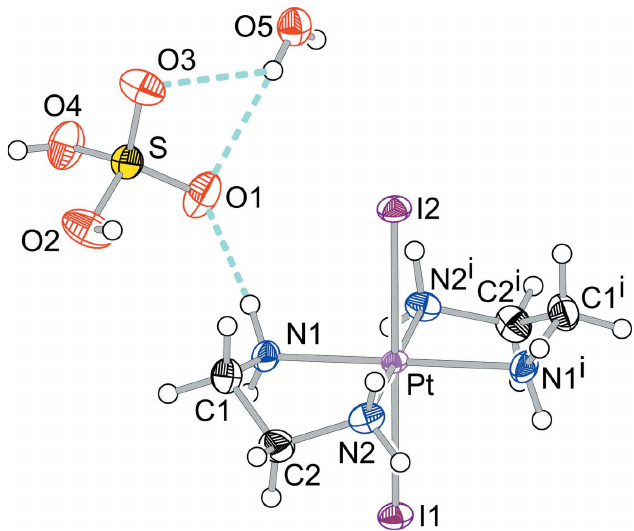
Figure 1 The structures of the molecular components of (I), showing the atomic numbering scheme. Displacement ellipsoids are drawn at the 50% probability level for non-H atoms. Light-blue dashed lines represent N— H (cid:2)(cid:2)(cid:2) O and O—H (cid:2)(cid:2)(cid:2) O hydrogen bonds. Each site of atoms I1 and I2 is half occupied. [Symmetry code: (i) 1